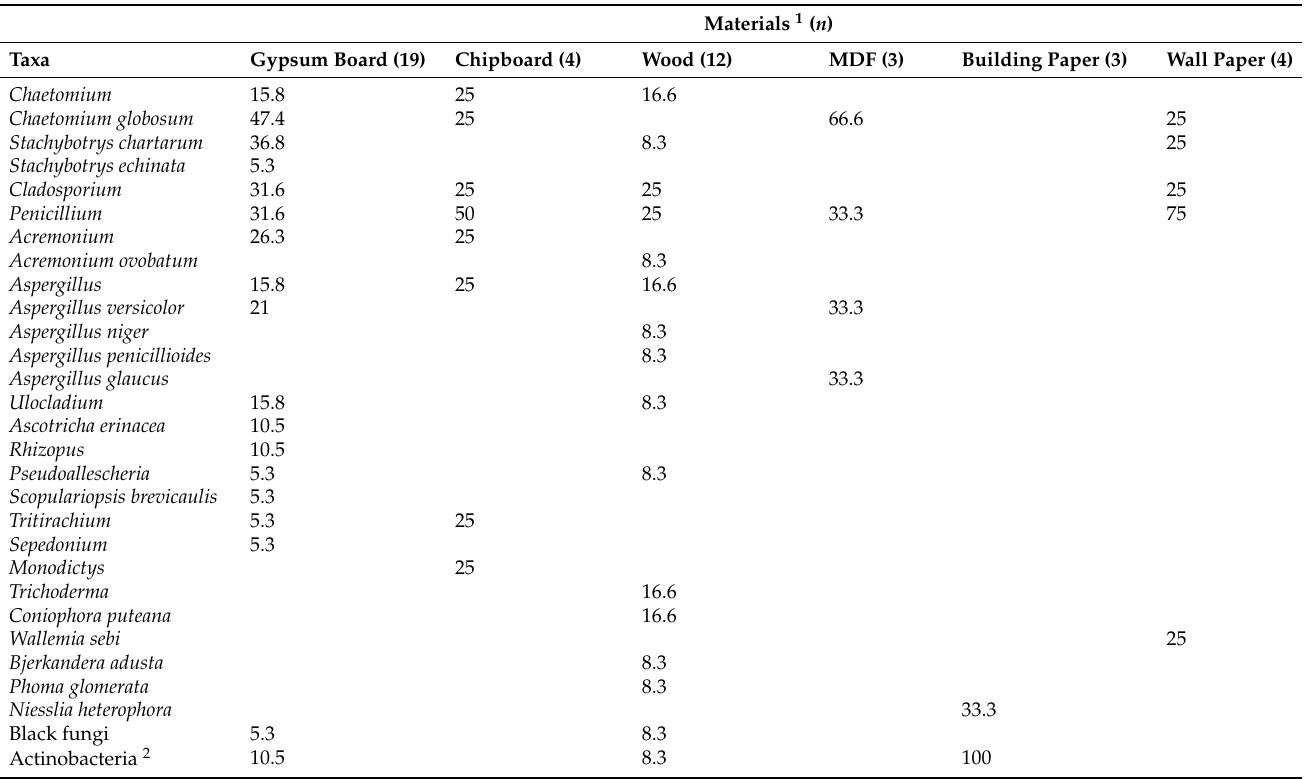
Table 1. Prevalence (% of samples) of fungal taxa reported by direct microscopy of tape lifts collected from mold-contaminated building